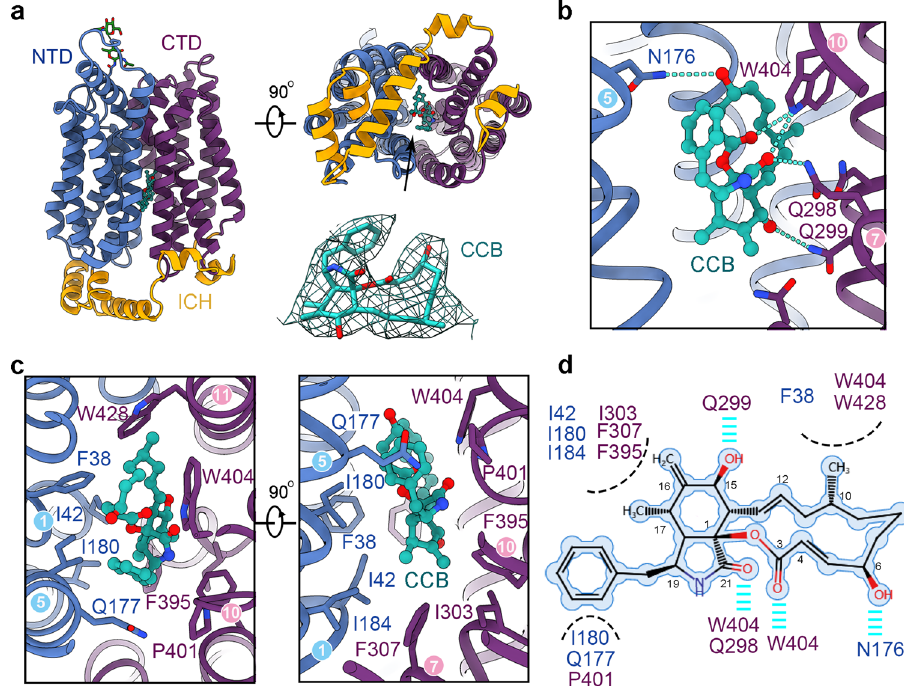
Fig. 2 Inward-open structure of GLUT4 bound to the endofacial inhibitor CCB. a Cryo-EM structure of GLUT4 in an inward-open state. Two perpendicular views of domain colored GLUT4 are shown. CCB, shown as green ball-and-sticks, binds to the central substrate binding site that is open to the intracellular side. The glycan on the extracellular side is shown as green sticks. The EM density for the bound CCB, shown as green mesh, is contoured at 4 σ . b Polar interactions between CCB and GLUT4. Key residues for inhibitor coordination are shown as sticks. The cyan dashed lines indicate hydrogen bonds. c Hydrophobic residues surrounding CCB. Two perpendicular views are shown. d A schematic presentation of CCB coordination by GLU4. Van der Waals contacts are indicated by black dashed curves, and hydrophilic interactions are indicated by cyan